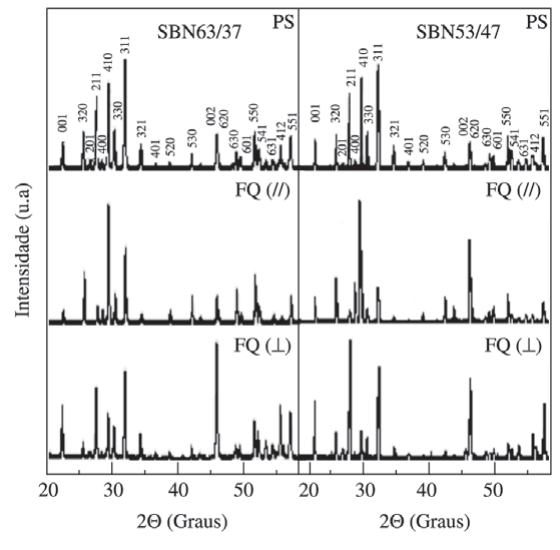
Figura 4. a) Representação do grão de uma cerâmica de SBN, cujo hábito de crescimento se dá ao longo da direção cristalográfica [001]; b) processo de texturização de cerâmicas usando forjamento a quente; c) arranjamento e/ou crescimento dos grãos alongados nos planos perpendiculares à direção de forjamento, porém em direções aleatórias nestes